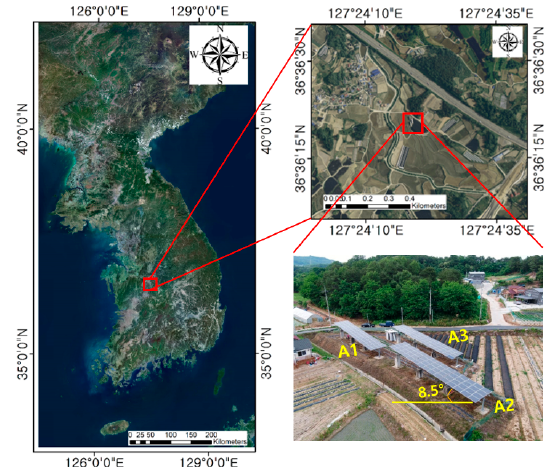
Figure 1. Location map of the Sooyoungro, Cheongju, Chungbuk in the Republic of Korea, which was photographed using unmanned aerial vehicles (UAVs) and optical